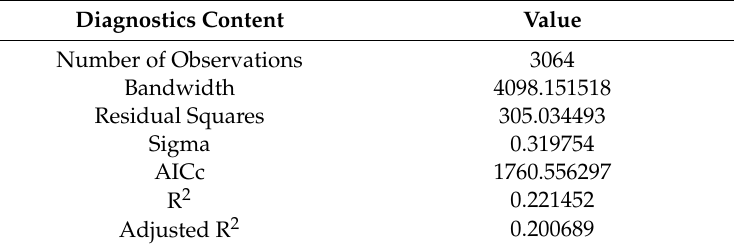
Table 5. Results of GWR